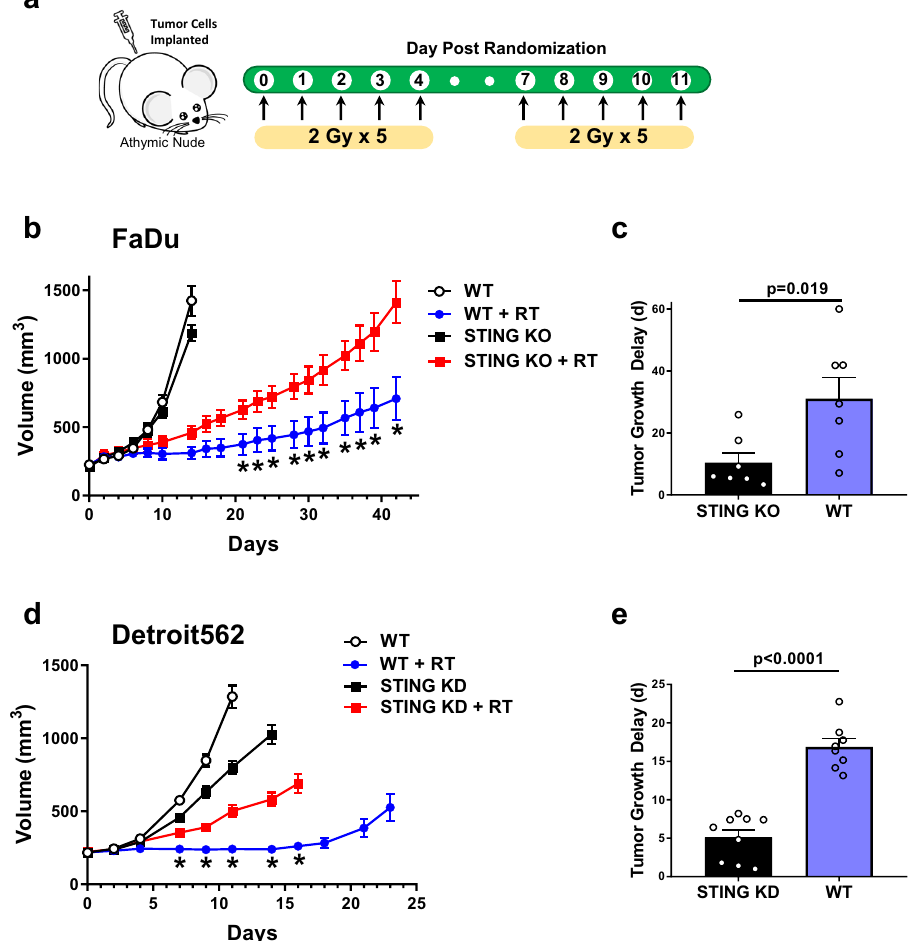
Fig. 2 STING controls the in vivo response to radiation. a Schematic of in vivo tumor growth delay experiments and fractionated treatment protocol with ionizing radiation. b Tumor growth curves for tumors generated from WT or STING KO FaDu cells implanted subcutaneously in athymic nude mice (error bars represent SEM for n = 6 for unirradiated groups and n = 7 for irradiated groups). * P -values for 21, 23, 25, 28, 39, 32, 35, 37, 39, and 42 days are 0.04, 0.02, 0.01, 0.005, 0.003, 0.0007, 0.0003, <0.0001, <0.0001, and <0.0001 based on two-way ANOVA with Fisher ’ s LSD post-hoc analysis without multiple comparison correction. c Quanti fi cation of tumor growth delay from radiation treatment (time to reach 600 mm 3 ) from b (error bars represent SEM of n = 7 WT tumors and n = 7 STING KO tumors; P -value from unpaired, two-tailed Student ’ s t test). d Tumor growth delay curves from WT or STING silenced Detroit562 tumors (error bars represent SEM of n = 9 tumors for STING KD + RT group and n = 8 for all others). * P -values for 7, 9, 11, 14, and 16 days are 0.049, 0.002, <0.0001, <0.0001, and <0.0001 based on two-way ANOVA with Sidak post-hoc multiple comparison